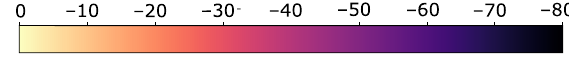
Figure 4. Spectrogram and onset detection function for a solo clarinet with the TKEO.